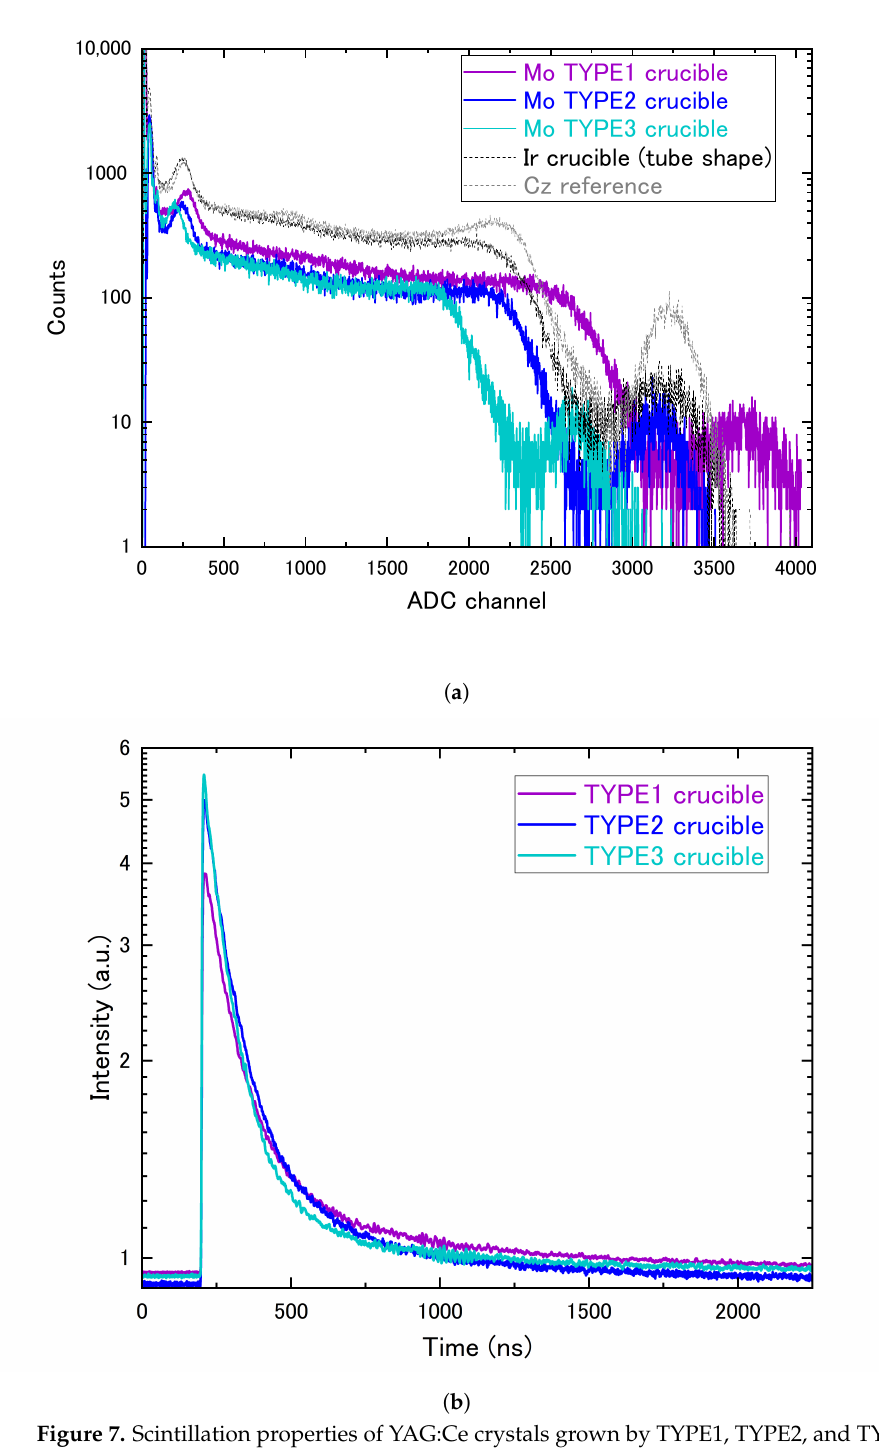
Figure 7. Scintillation properties of YAG:Ce crystals grown by TYPE1, TYPE2, and TYPE3 crucibles. The pulse height spectra of Cz grown crystal and tube-YAG:Ce grown by Ir crucibel are also shown in ( a ). ( a ) Pulse Height Spectra irradiated by 137 Cs source. ADC channel stands for “Analog-to-Digital Converter channel”. ADC channels represents the amplitude of the waveform. The 137 Cs 662 keV photopeaks were observed in all samples. ( b ) Average waveforms of 512